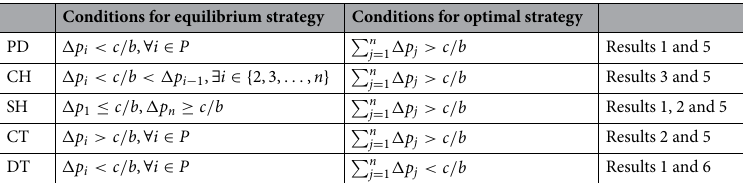
Table 5. Conditions for the n -player extension of two-by-two